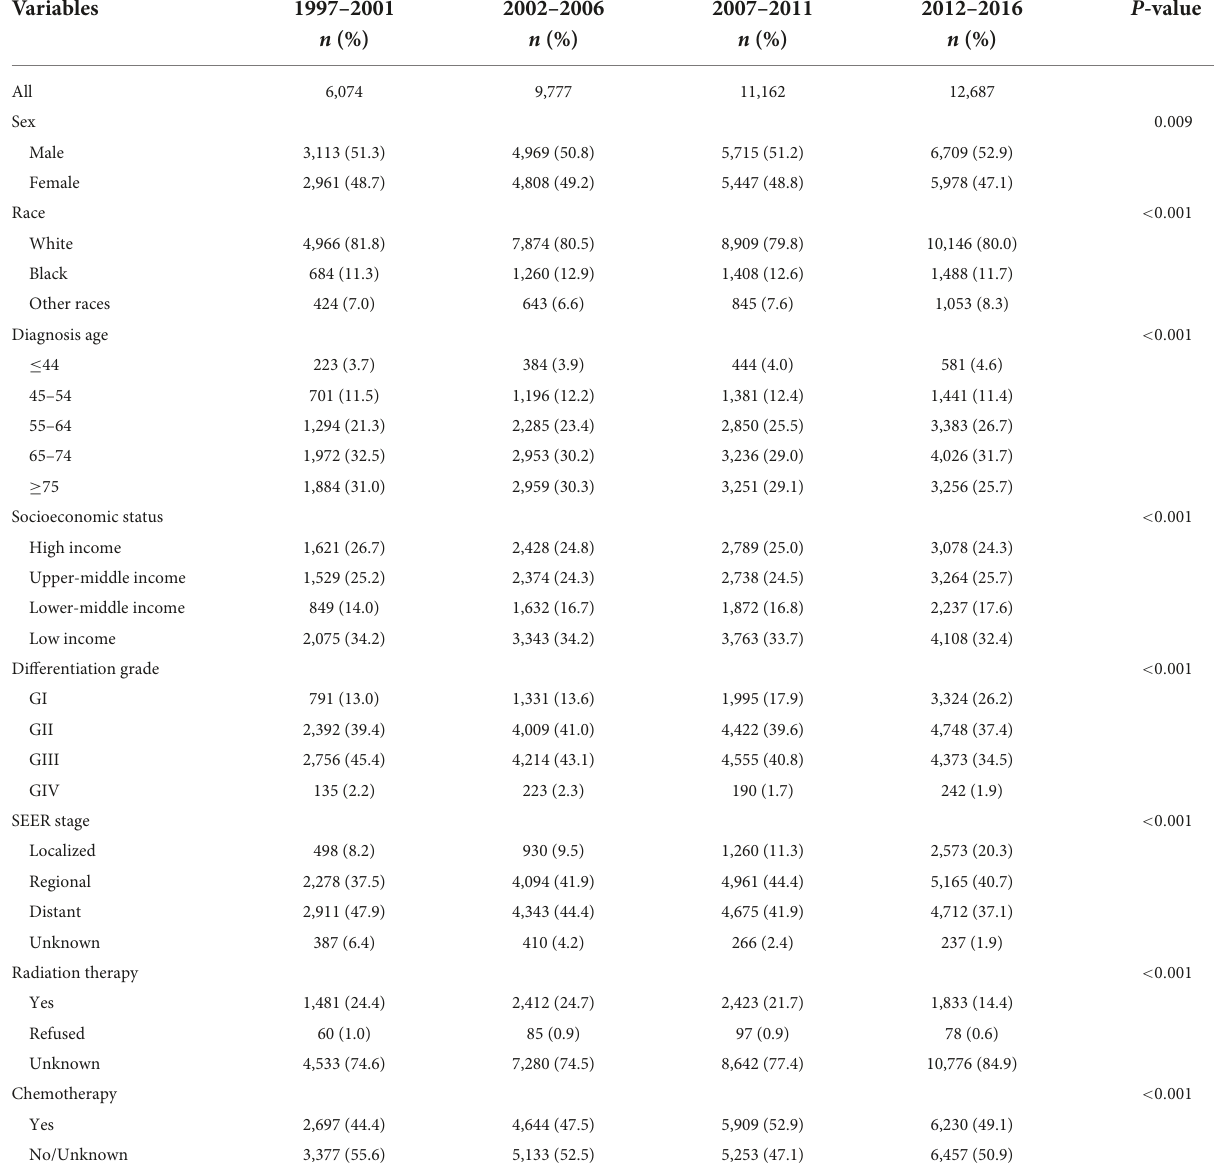
TABLE 1 Distribution of pancreatic cancer (PC) cases from 1997 to